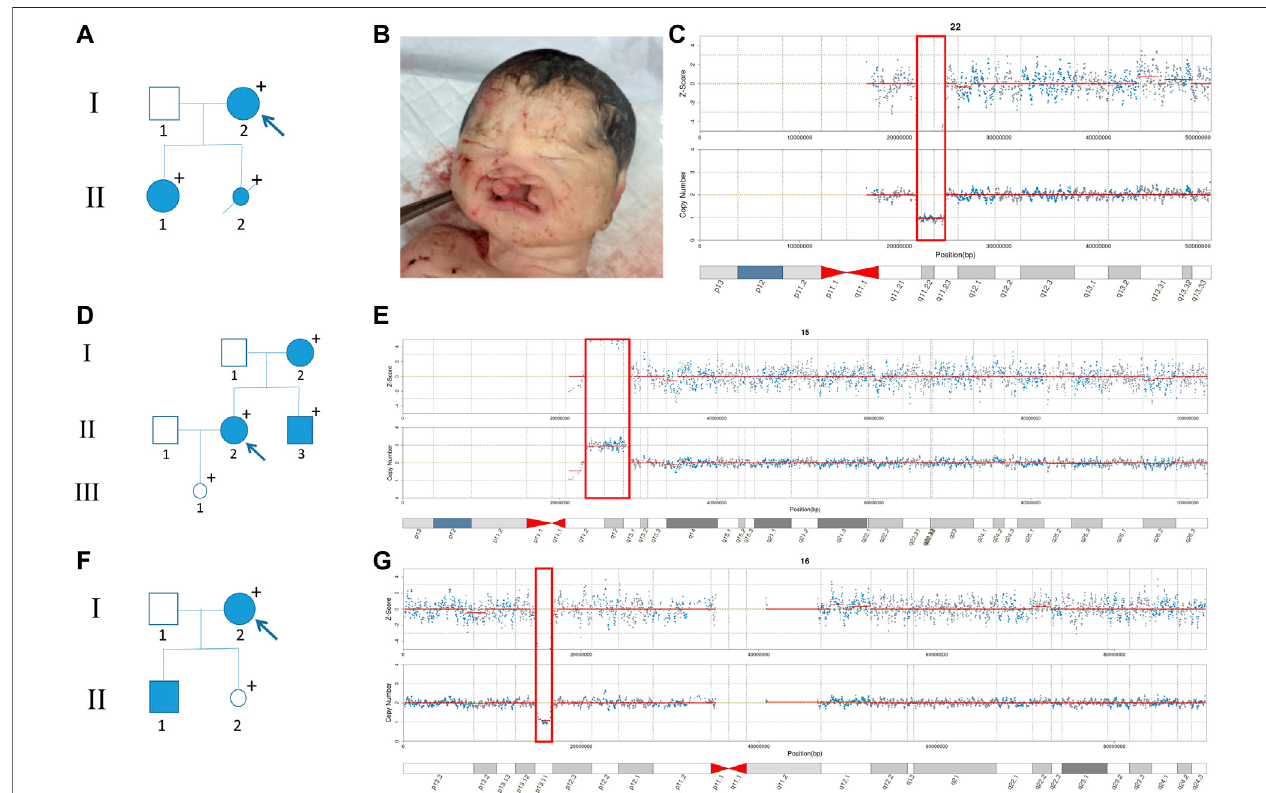
FIGURE 3 | Family pedigrees with maternal CNVs. (A) Family pedigrees of No. 21J101249. (B) The facial phenotype of post-induction fetus (No. 21J101249), including cleft lip and palate. (C) Maternal CNV of No. 21J101249 suggested by NIPT. (D) Family pedigrees of No. 21J108971. (E) Maternal CNV of No. 21J108971 suggested by NIPT. (F) Family pedigrees of No. 21J100568. (G) Maternal CNV of No. 21J100568 suggested by